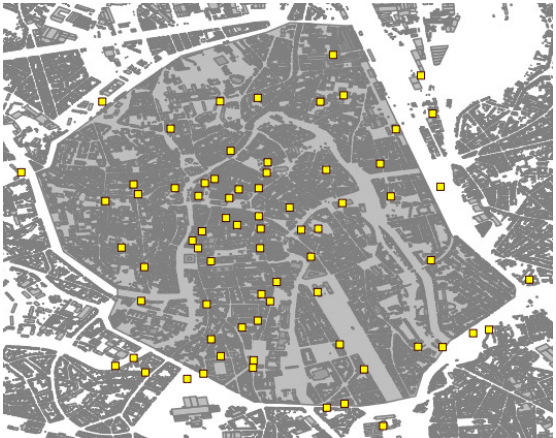
Figure 2. Selected area in Ghent, Belgium and the possible location of the base